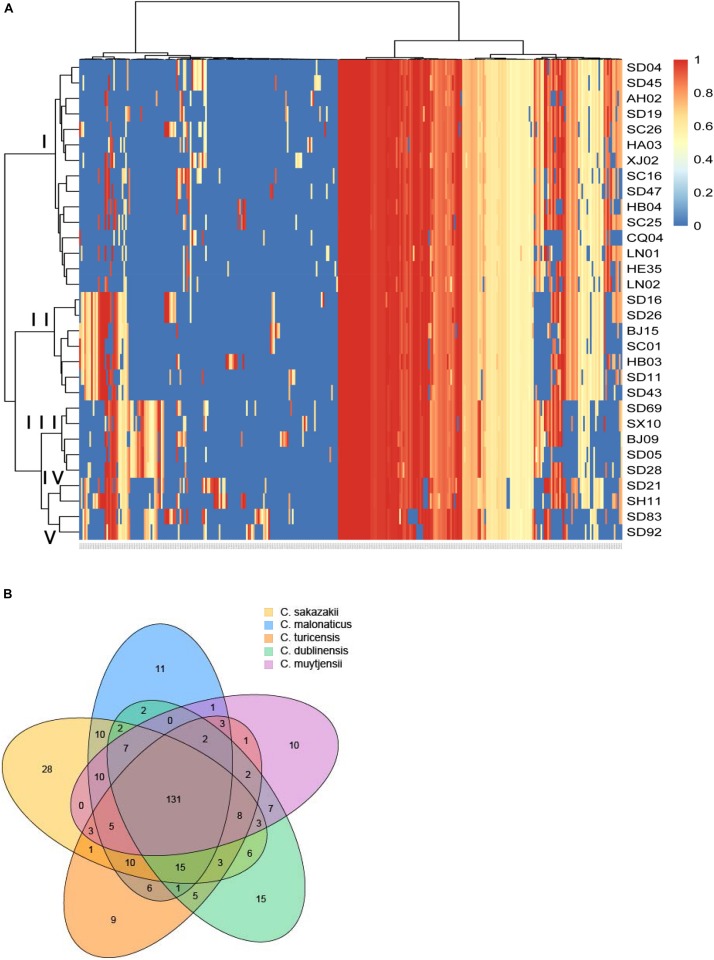
Genome analysis of virulence genes for different species of Cronobacter isolates. (A) Hierarchically clustered heatmap of the virulence genes distribution of 31 Cronobacter isolates. The heatmap plot depicts the sequences coverage value of virulence genes (horizontal axis clustering) within each isolate (variables clustering on the vertical axis). The sequences coverage value of virulence genes are indicated by color intensity with the legend indicated at the right top of the figure. (B) Sequence diversity and functional enrichment across clustered genes. Virulence genes from each species were clustered using OrthoFinder v.0.7.1. This yielded 319 genes, shown here using draw quad. venn from the VennDiagram package of Rstudio v.3.0.2. Ovals with no cross indicate singleton genes possessed by every species of Cronobacter, and ovals with cross represent clusters of genes that have orthologs and paralogs for different species of Cronobacter.